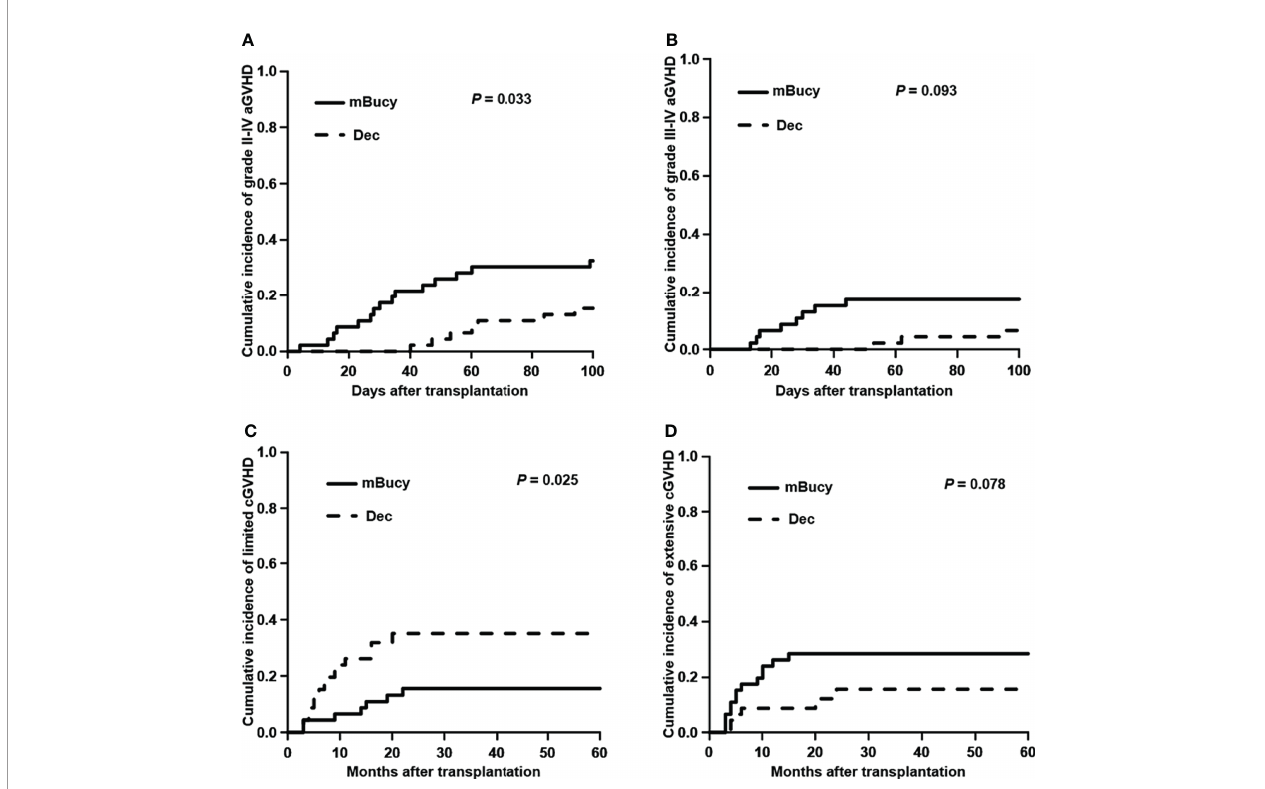
FIGURE 1 | Cumulative incidence of (A) grade II – IV acute graft-versus-host disease (aGVHD), (B) grade III – IV aGVHD, (C) limited chronic GVHD (cGVHD), and (D) extensive cGVHD in the decitabine (Dec) group and the modi fi ed busulfan/cyclophosphamide (mBuCy) group.